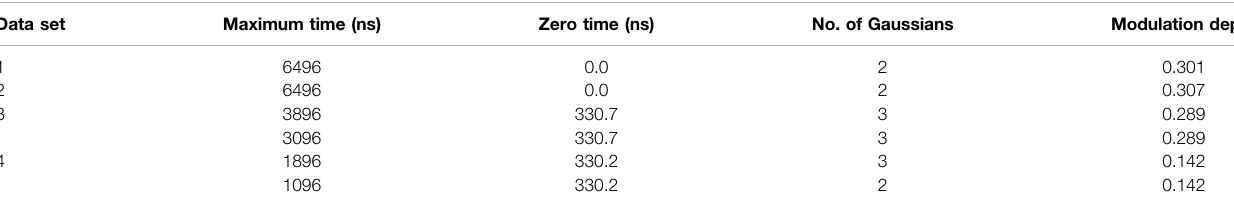
TABLE 2 | DD parameters. Data set